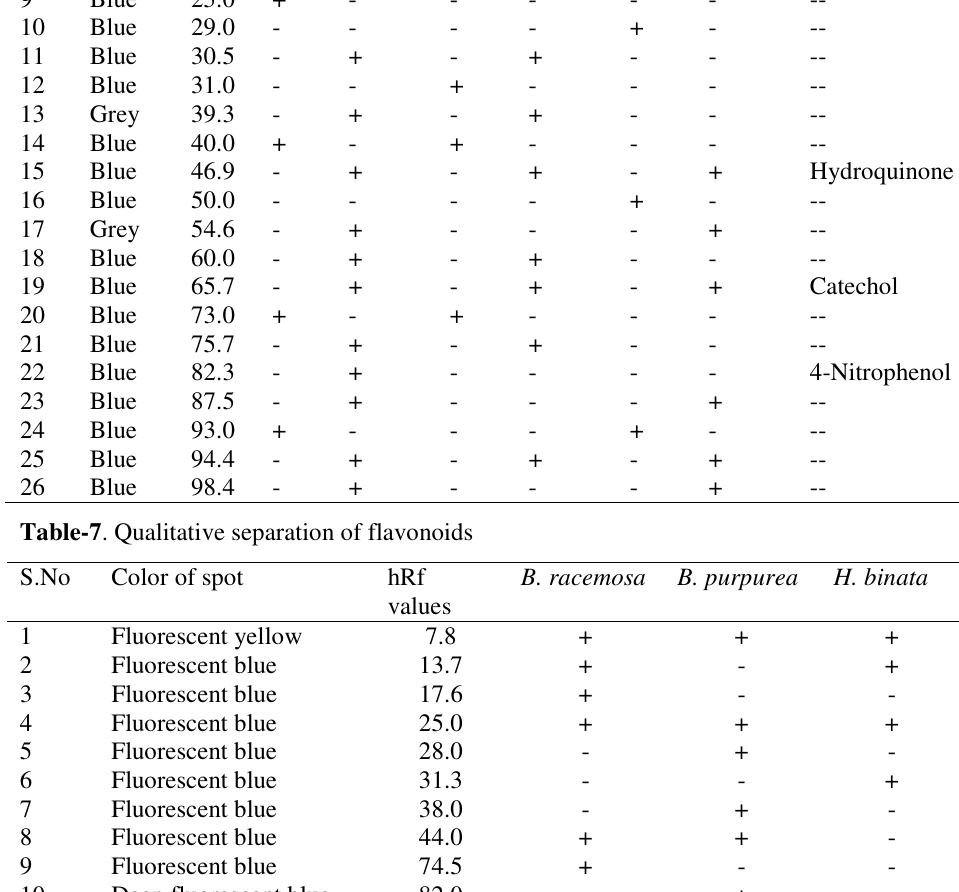
Table-6 . Qualitative separation of phenols